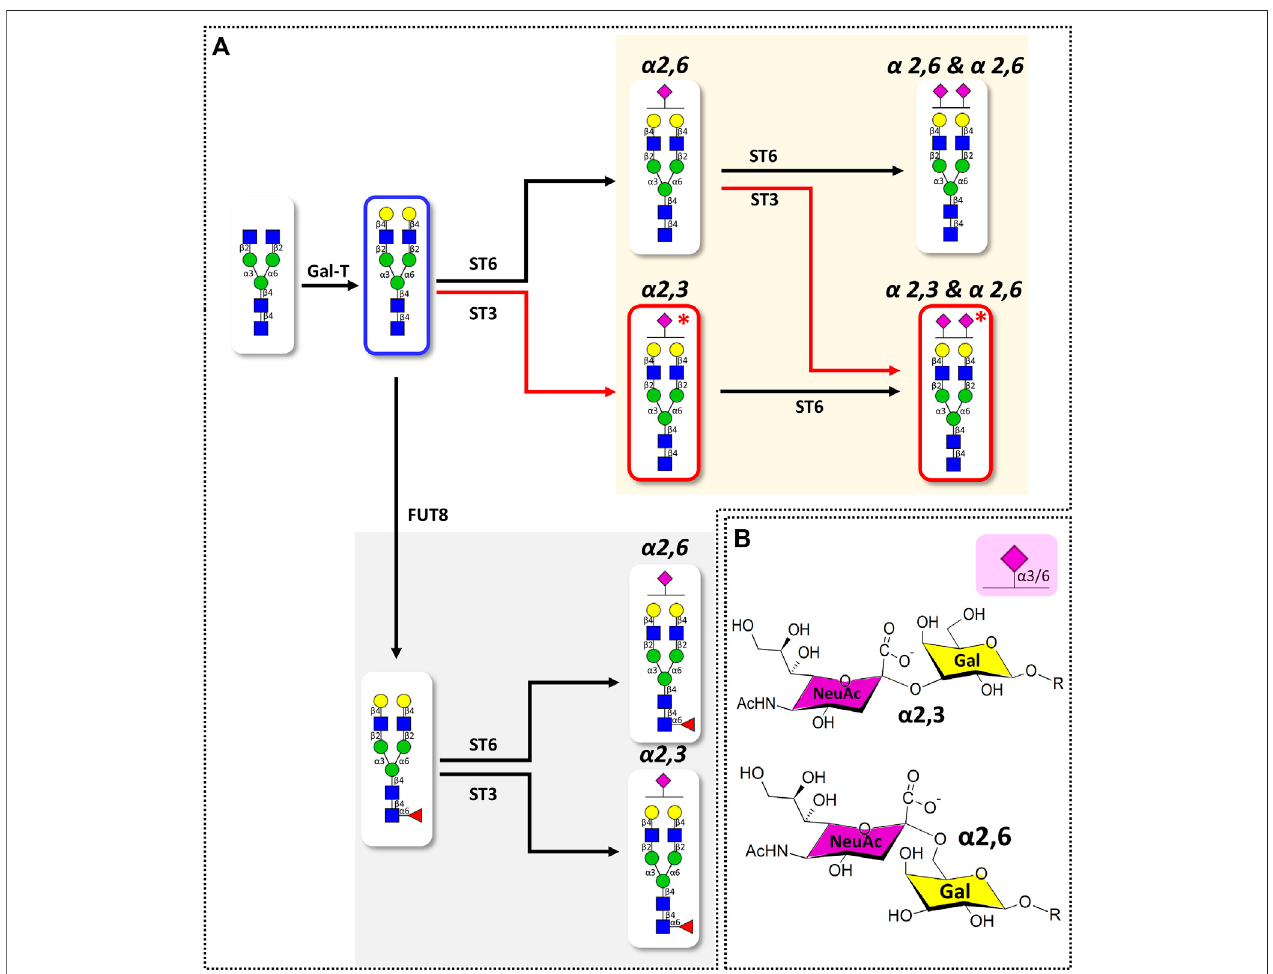
FIGURE 2 | (A) Simpli fi ed biosynthetic pathway of target sialylated biantennary N -glycans and (B) the representative structures of terminal sialic acid epitopes in humans. Pathway and glycans associated with BD-speci fi c sialic acid epitope are highlighted with red lines. Glycosyltransferases involved in the glycan synthesis are indicated at the top of the arrow (GalT: β 1,4 galactosyltransferase; FUT8: α 1,6 fucosyltransferase; ST6: α 2,6 sialyltransferase; ST3: α 2,3 sialyltransferase). Glycan structures were represented using SNFG nomenclature (Varki et al., 2015). Glycan schematic symbols: green circle, mannose; yellow circle, galactose; blue square, N -acetyl glucosamine; red triangle, fucose; purple diamonds, N -acetylneuraminic